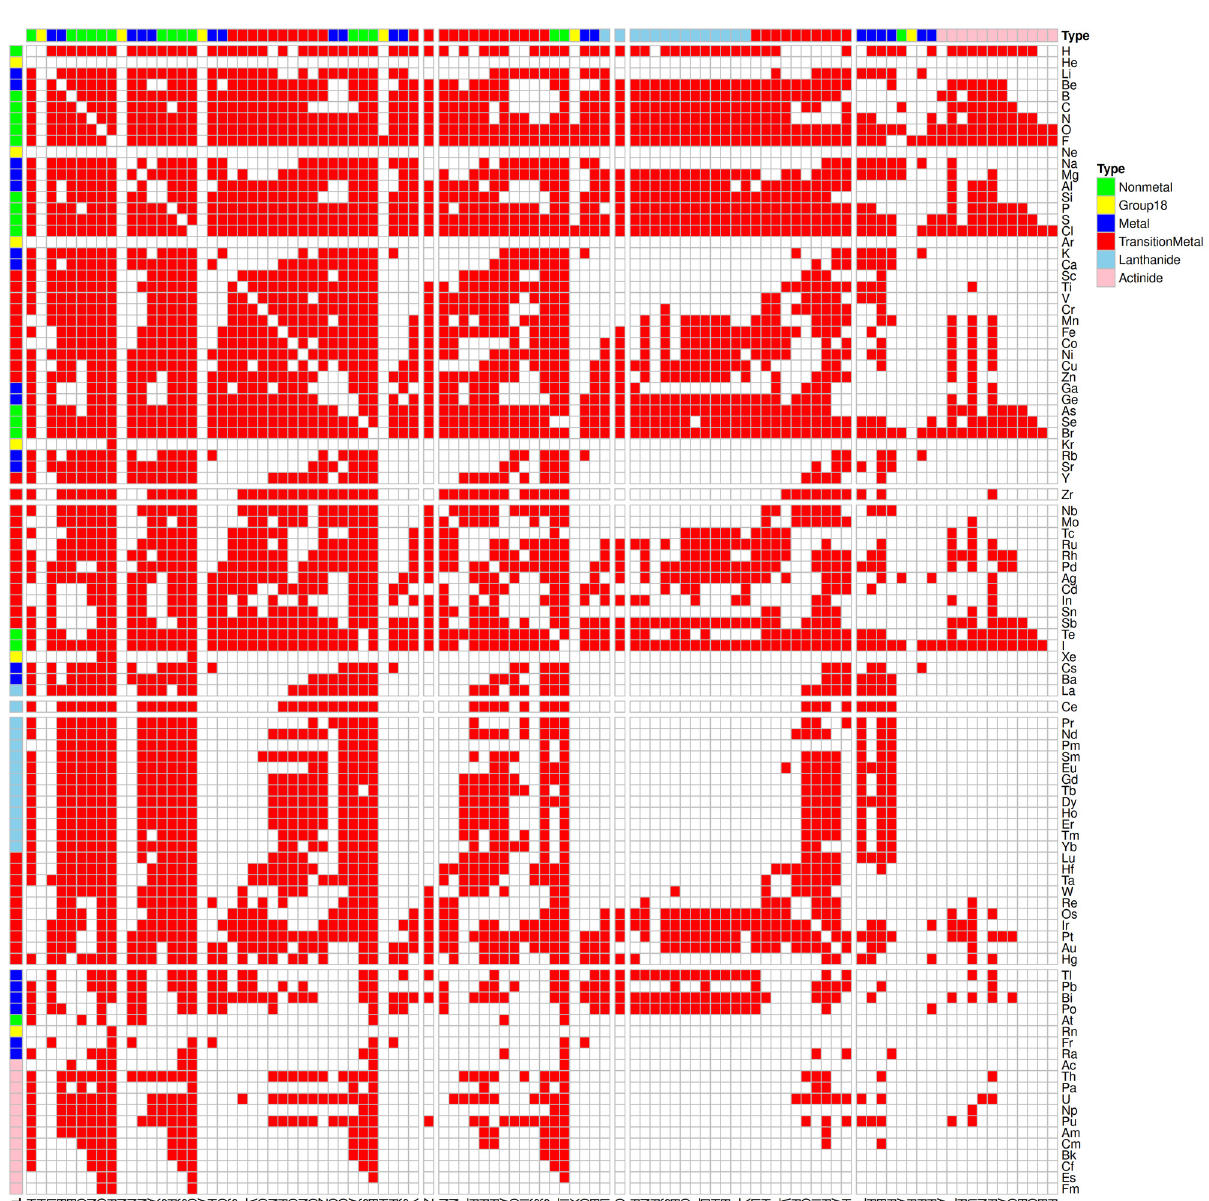
Figure 2: The bonding element pair